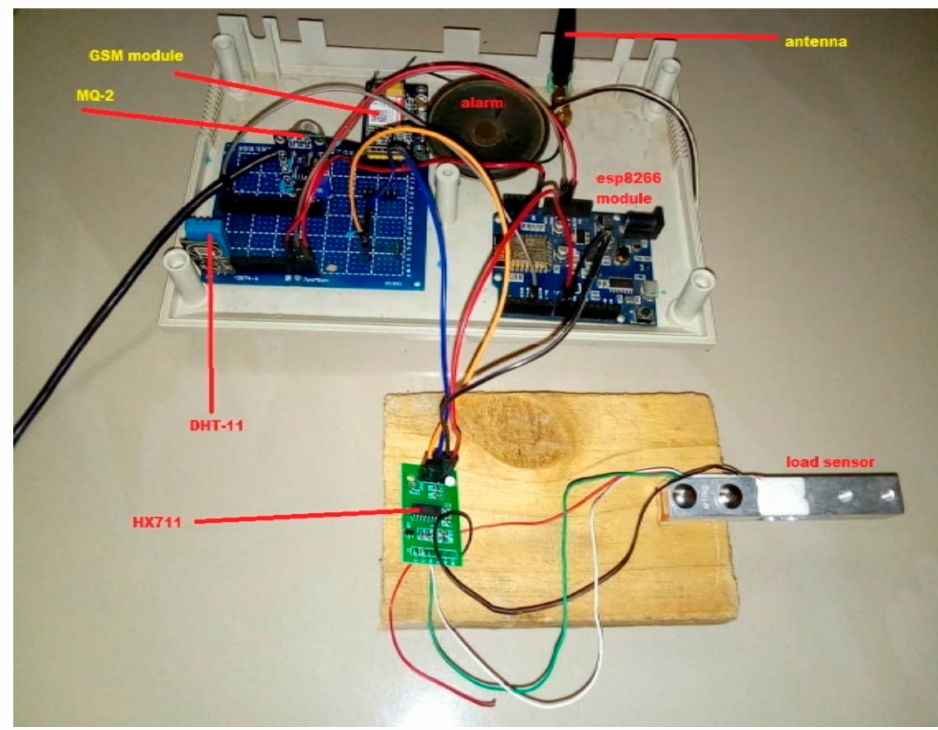
Figure 13. Lab-based experiment of the